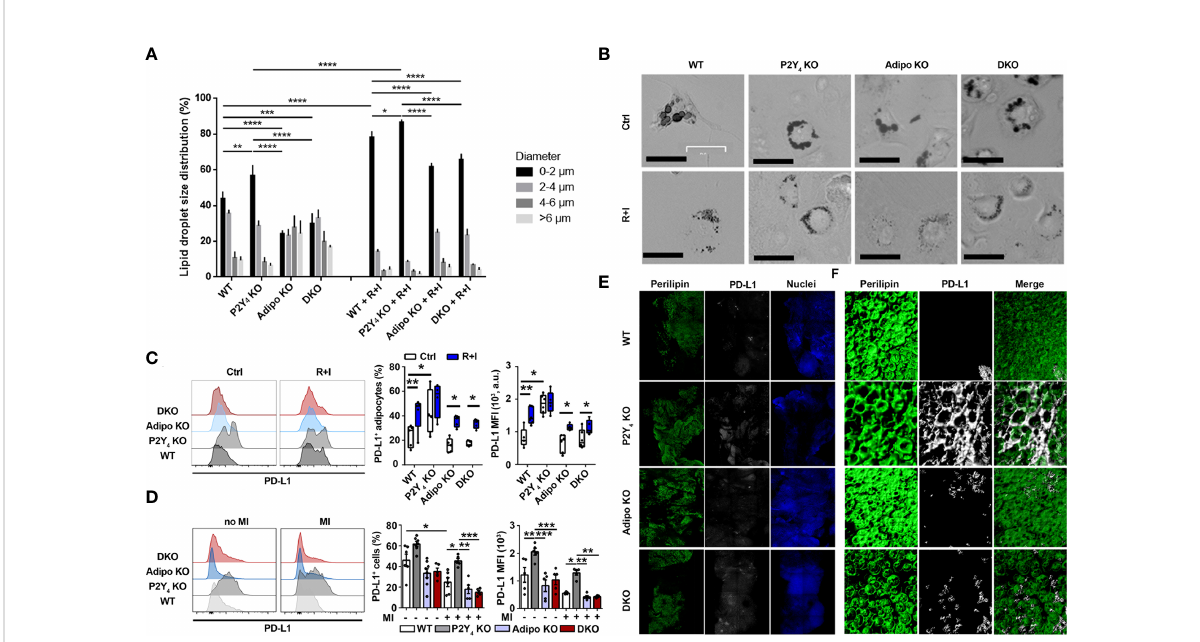
FIGURE 2 Identi fi cation of PD-L1 as a marker of beige adipocytes, upregulated in P2Y 4 KO PAT. (A) Quanti fi cation of lipid droplet size in adipocytes generated from WT, P2Y 4 KO, Adipo KO and DKO cADSCs in the presence or absence of R+I treatment. Quanti fi cation was performed using ImageJ software (n = 4). (B) Oil red O staining of cardiac adipose-derived stem cells (cADSC) cultures after adipogenic differentiation and after treatment with two adipocyte browning agents, rosiglitazone (1 µM) plus isoproterenol (100 µM) (R+I) (200x magni fi cation). Adipogenic differentiation leads to big lipid droplet appearance in control (Ctrl) cADSC cultures. The additional presence of browning agents (R+I) in the differentiation medium leads to small lipid droplet appearance in cADSC cultures. (C) Higher PD-L1 expression in P2Y 4 KO differentiated cADSCs. Density plots, percentage of PD-L1 positive cells and mean fl uorescence intensities (MFI) obtained by fl ow cytometry quanti fi cation